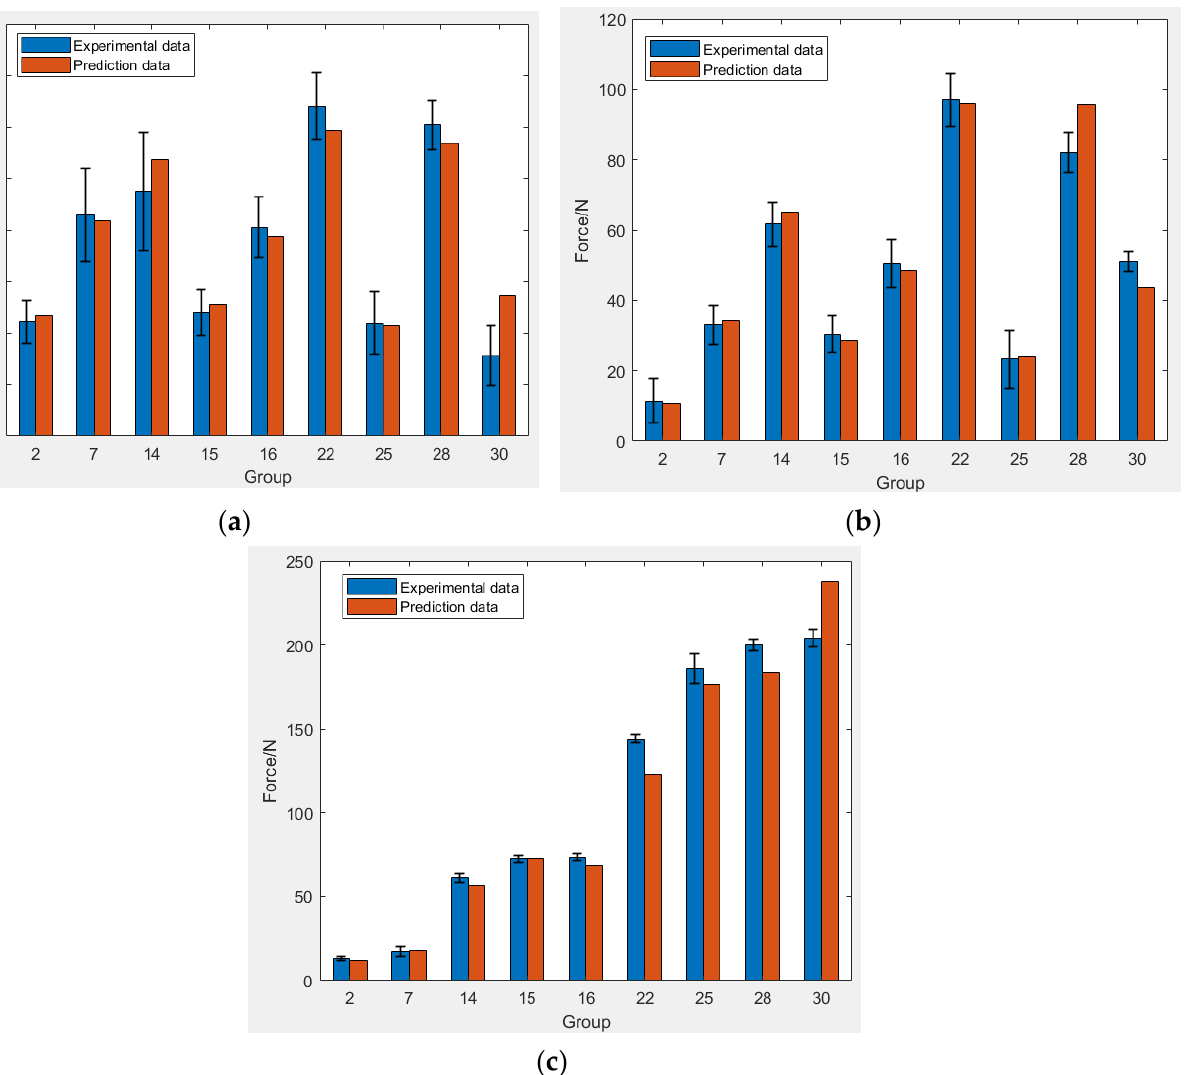
Figure 3. Comparison of experimental and predicted values of three-way milling force. ( a ) F x ; ( b ) F y ; ( c ) 𝐹